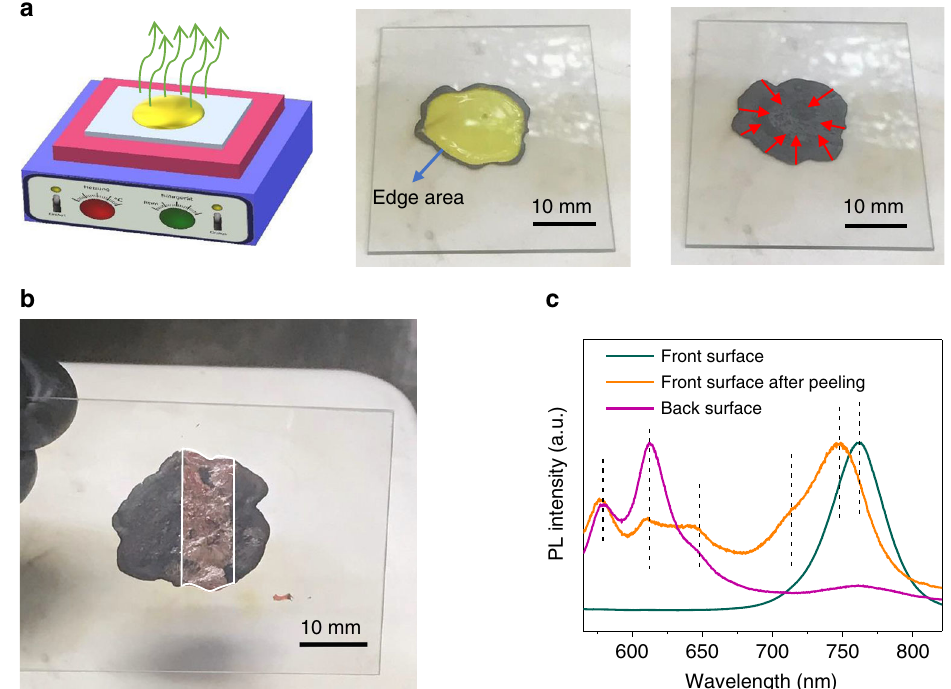
Fig. 5 Optical images and photoluminescence (PL) spectra of top-crust peeling-off test. a Schematics of top-crust peeling-off test setup. A glass substrate (40 mm × 50 mm) with 100 µ L BA 2 MA 3 Pb 4 I 13 precursor solution (2 M in N,N -dimethylformamide (DMF)) on top was placed on a hot plate at 70 °C. The yellow solution begun to turn dark in the edge, and this dark area gradually spread into the center as indicated by the red arrows, forming a top-crust. b A Kapton tape was used to partially peel off the top-crust, and the revealed yellow precursor solution underneath that has not yet crystallized started to turn red under heating. After the solution had dried, the glass substrate was removed from the hot plate. The area inside the white frame represented the crystallized front surface revealed after the top-crust was removed by Kapton tape. c PL spectrum of different areas in